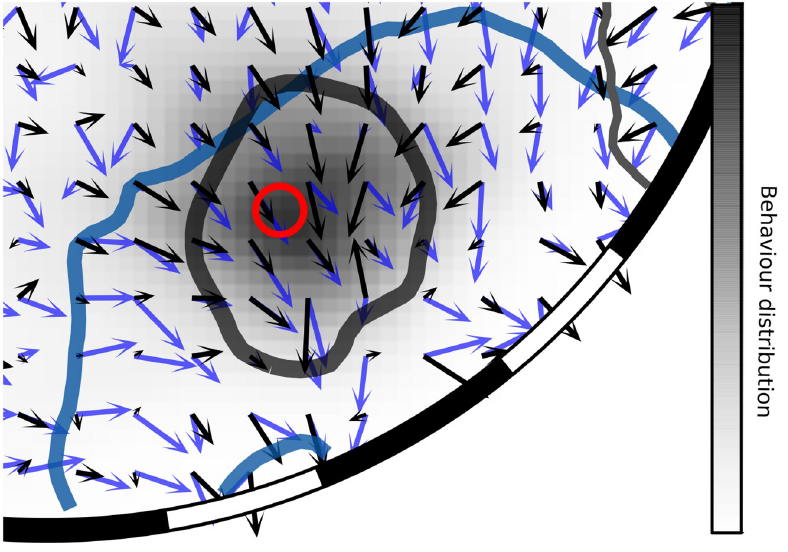
Fig 8. Details of the field of homing vectors for the CwN4-model and for the B8-model. The CwN4-model’s vector field is represented in blue, with the lowest isohypse of its derived potential in dark blue. The B8-model’s vector field is in black with the lowest isohypse of its potential in black. The distribution of the behaviour is represented by a black gradient from white to black. The red circle indicates the location of the stripes’ fictive nest.